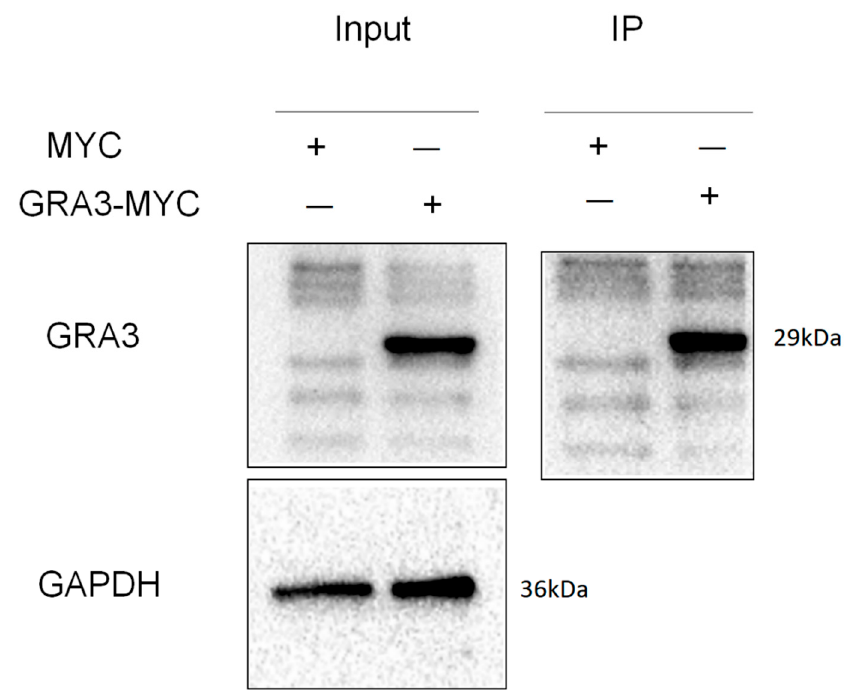
Figure 6. Immunoprecipitation assay of total protein from 293T cells infected by T. gondi ME49 strain using GRA3 PcAb. Input group contains GRA3 protein. IP group indicates that the precipitate contains this protein. GAPDH was used as a loading control.